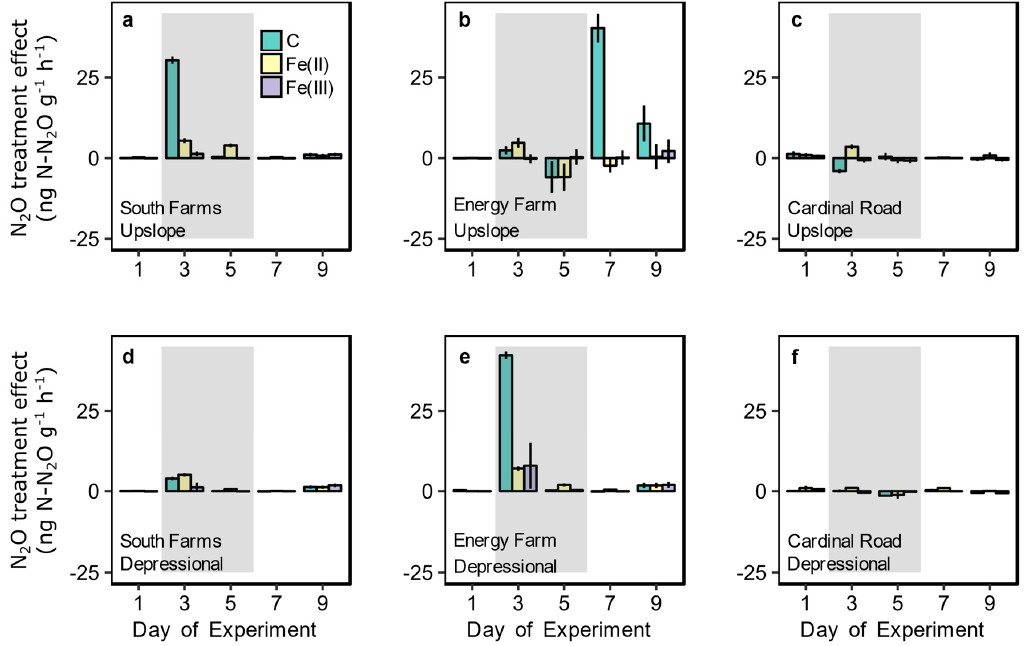
Table 2. Results from ANOVAs run on mixed effects models examining the treatment effect on soil N 2 O emissions during the late season lab experiment.